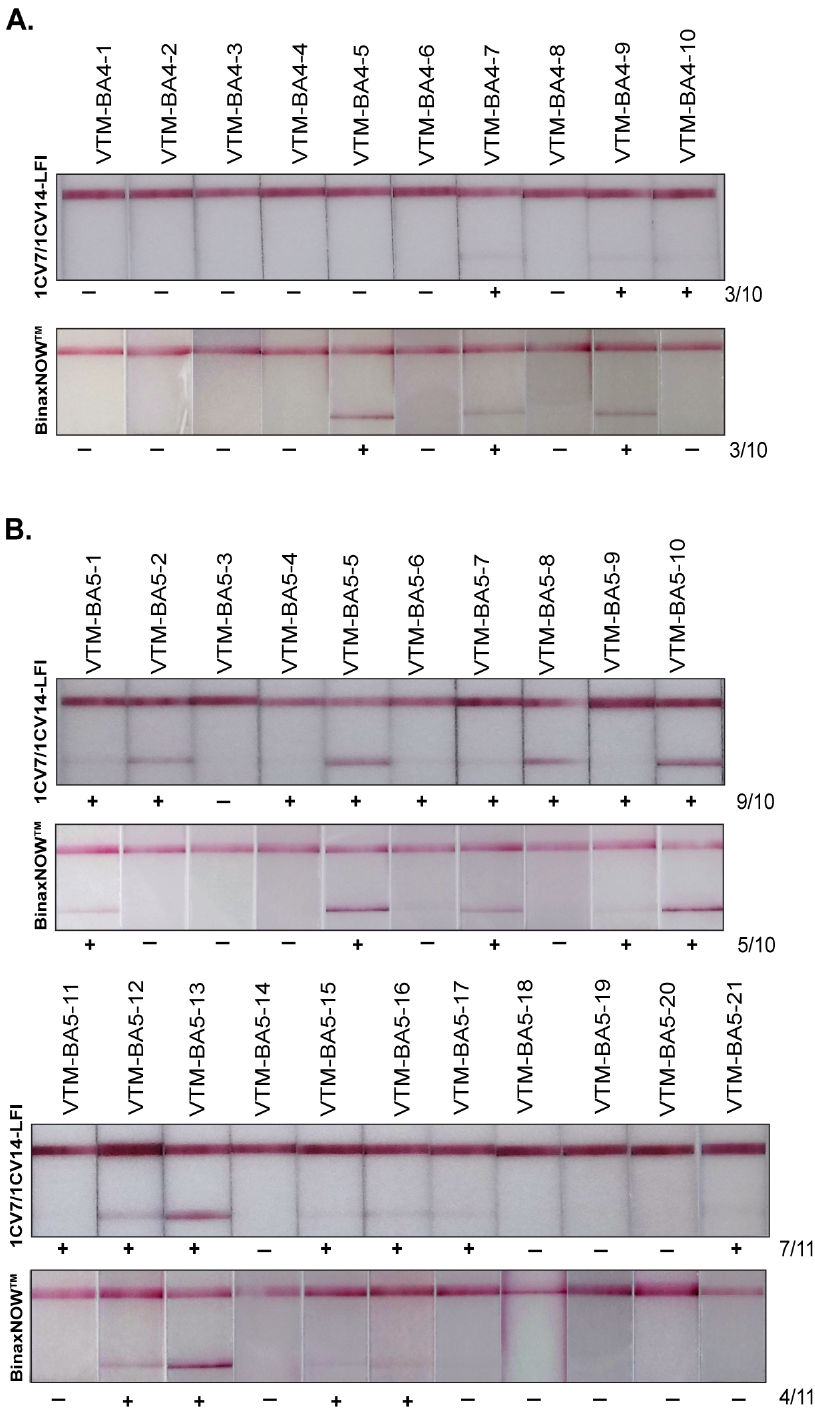
Figure 5. Sensitivities of 1CV7/1CV14 LFIs in comparison with BinaxNOW TM for the detection of Omicron BA.4 ( A ) and BA.5 ( B ).